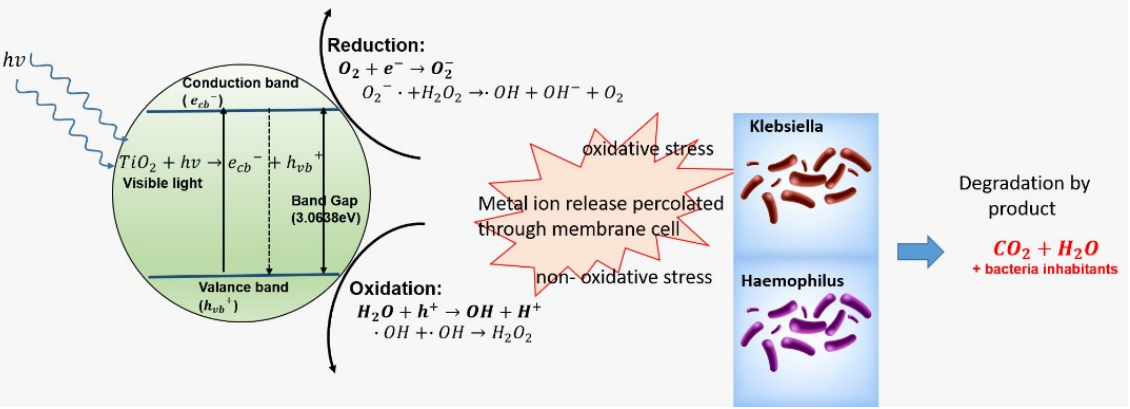
Figure 1. Photocatalytic mechanism.